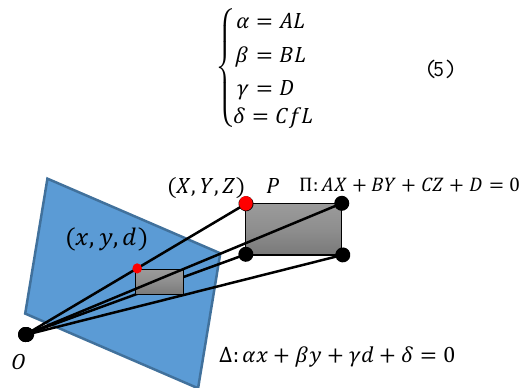
Figure 3. Disparity-to-spatial relationship for planar